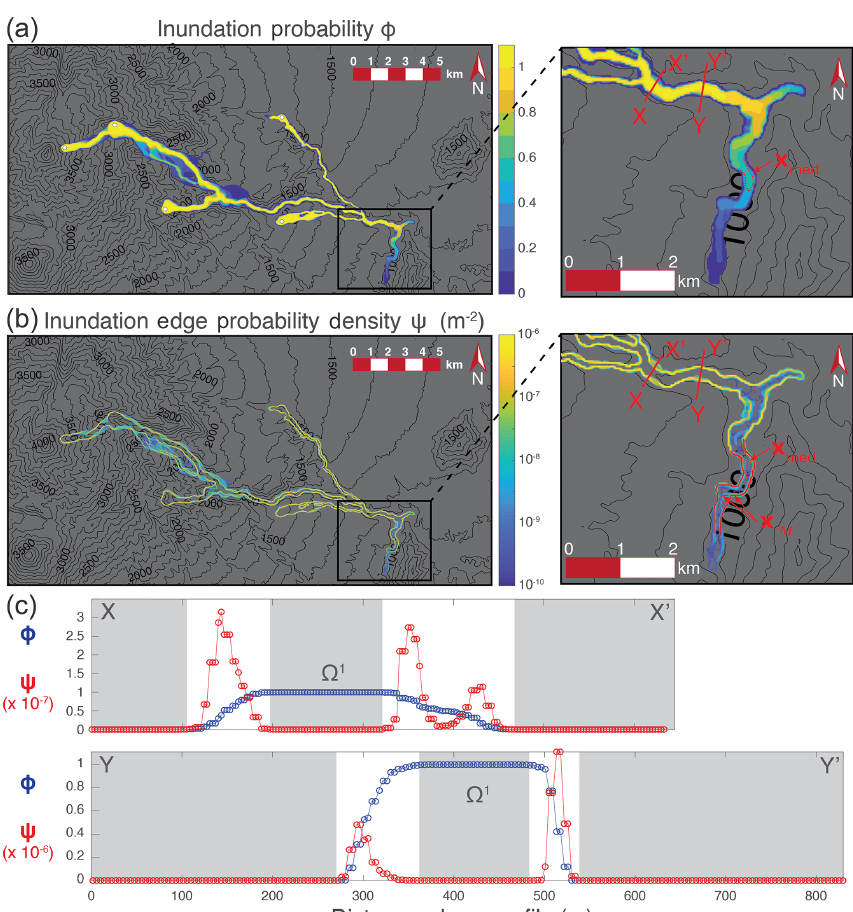
Figure 4. (a) PHM and (b) PHDM for a lahar inundating Atenquique, Mexico, using the numerical model TITAN2D incorporating the parameter space described in the text. (c) Profiles of the PHM and PHDM across sections X–X (cid:48) and Y–Y (cid:48) highlighting the fact that each side of the PHM profile acts as a CDF for the location of the inundation edge with the corresponding scaled PDF given by the same profile along the PHDM. Grey background (c) indicates regions where φ = 0 or φ = 1 ( ψ =